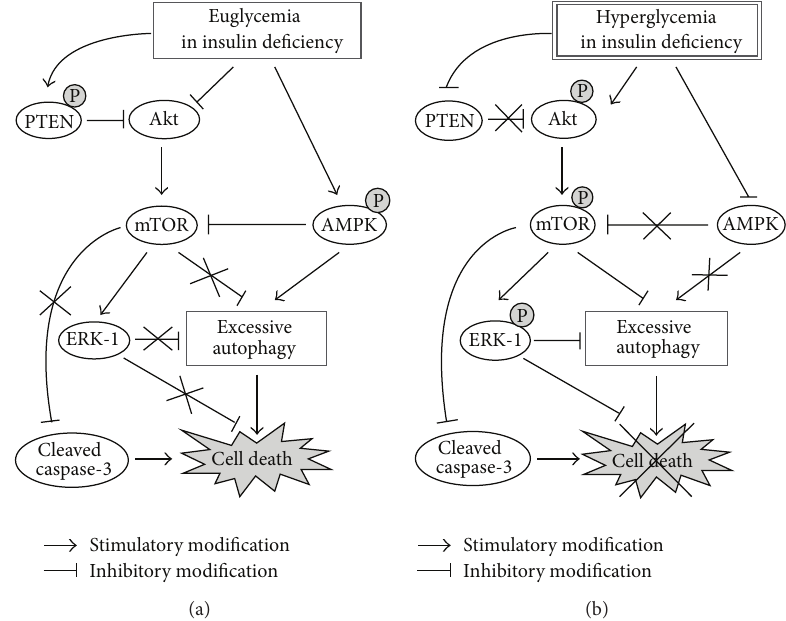
Figure 7: Proposed molecular mechanisms for (a) the loss or (b) the preservation of liver weight by glycemic levels in the presence of insulin deficiency. In the liver of euglycemic rats with insulin deficiency, AMPK is activated and the activity of Akt, a major insulin signaling molecule, decreases (the decreased Akt activity is also influenced by PTEN activation), compared with those in hyperglycemic rats with insulin deficiency. The increased AMPK and decreased Akt activities, in turn, decrease the activity of mTOR. As a result, excessive autophagy is induced not only by the activated AMPK but also by the inhibition of protective role of mTOR against autophagy through ERK-1 activation and caspase-3 inhibition. Then excessive autophagy leads to hepatic cell death, partially via apoptosis mediated by caspase-3 activation, resulting in the loss of liver weight in euglycemic rats with insulin deficiency. On the other hand, in the liver of hyperglycemic rats with insulin deficiency, AMPK is not activated while Akt and mTOR are activated, compared with those in euglycemic rats with insulin deficiency. Thus, excessive autophagy and hepatic cell death are prevented not only because of the protective role of mTOR against autophagy but also because of the low AMPK activity, resulting in the preservation of liver weight in hyperglycemic rats with insulin